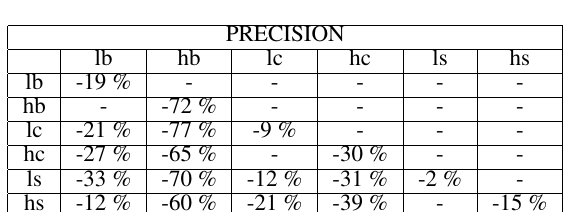
Figure 3. Comparison of the ground truth and segmentation results when predicting the segmentation maps of unaltered images (b) and pictures with lower contrast and lower saturation